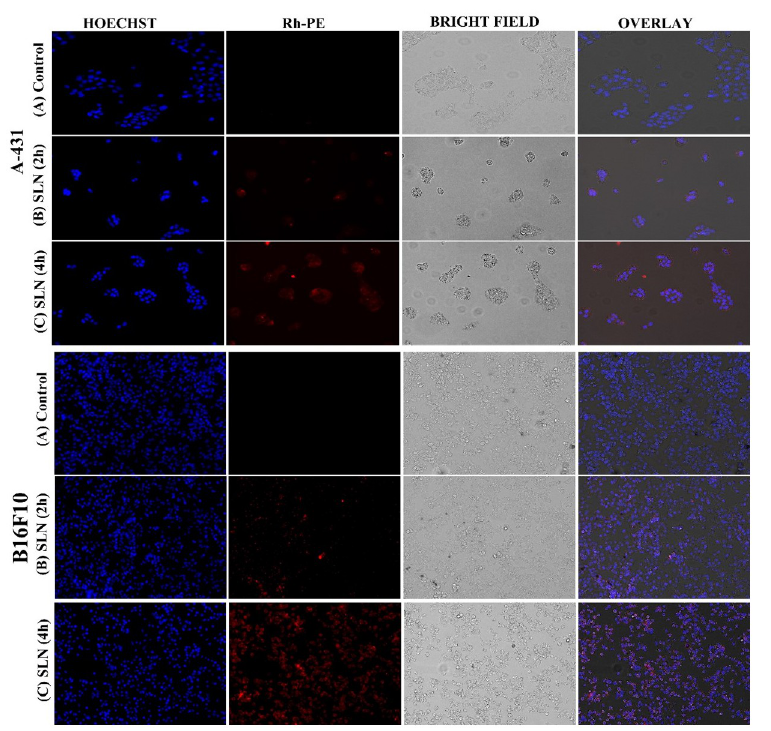
Fig 8. Qualitative cellular uptake studies of control vs treated cells with